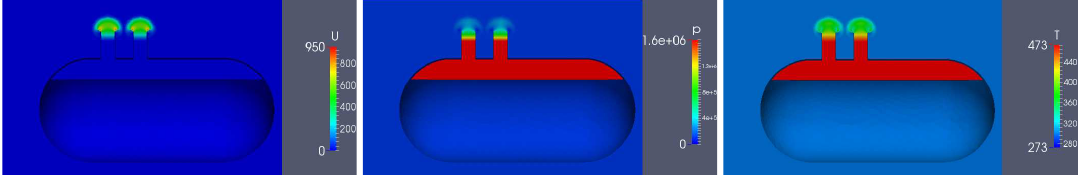
Figure 7. The velocity, pressure and temperature distribution in PRT and interior space at 0.001 s.